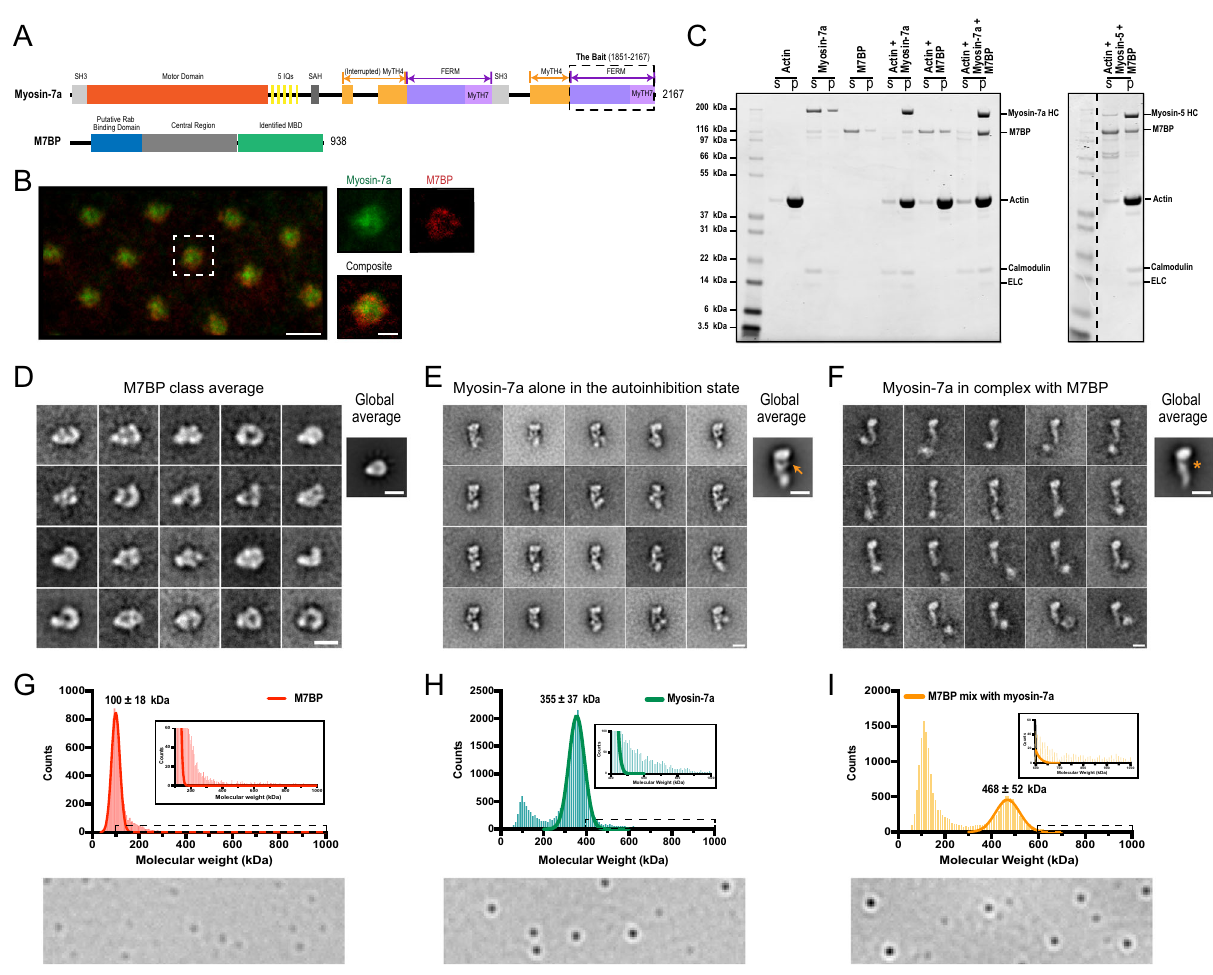
Fig. 1 M7BP is a bona fi de binding partner for myosin-7a that relieves its state of autoinhibition. A Domain organizations of myosin-7a and the identi fi ed binding protein M7BP (Schematics are in scale with the length of their primary sequences). Numbers indicate the positions of amino acid residues. B Immuno fl uorescence staining of eye imaginal discs of third instar larvae with anti-myosin-7a (green) and anti-M7BP (red) antibodies. Scale bar = 5 μ m in the left panel and 2 μ m in the right panels of magni fi ed images. C SDS-PAGE analysis of actin co-sedimentation assays. Fractions of supernatant (S) and pellet (P) isolated from mixtures of actin, myosin-7a, M7BP, or myosin-5 after ultracentrifugation were indicated. D Class averages from negative-stain EM images of M7BP in 150 mM salt buffer, showing an asymmetric globular structure. Scale bars = 10 nm. E , F Class averages from EM images of myosin-7a alone ( E ) and myosin-7a in complex with M7BP ( F ) in 150 mM salt buffer with ATP. Myosin-7a alone exhibits a compact, autoinhibited conformation in which the distal end of the folded tail contacts the motor domain (see orange arrow in the global average image). In the presence of equimolar M7BP, the complex exhibits a more extended conformation with concomitant loss of contact between the tail and the motor domain (orange asterisk), indicating a release of autoinhibition due to M7BP binding. Scale bars = 10 nm. G – I Interferometric single-molecule mass photometry assays. Histograms (bin width = 10 kDa) of single particle mass values (presented as molecular weight) for the indicated protein or protein complex. Lines are the Gaussian fi t to the data yielding the molecular weights of samples. The small peak at ~100 kDa mass in H was attributed to multiple proteolytic products around this size that were also shown by SDS-gels in C . Insets: Zoom of the regions for larger species. Bottom: A singe frame of differential interferometric scattering images in each assay. N = 9063 M7BP molecules ( G ), N = 25,773 myosin-7a molecules ( H ), and N = 18,826 myosin-7a + M7BP complexes ( I ). Molecule landing events were collected over three independent